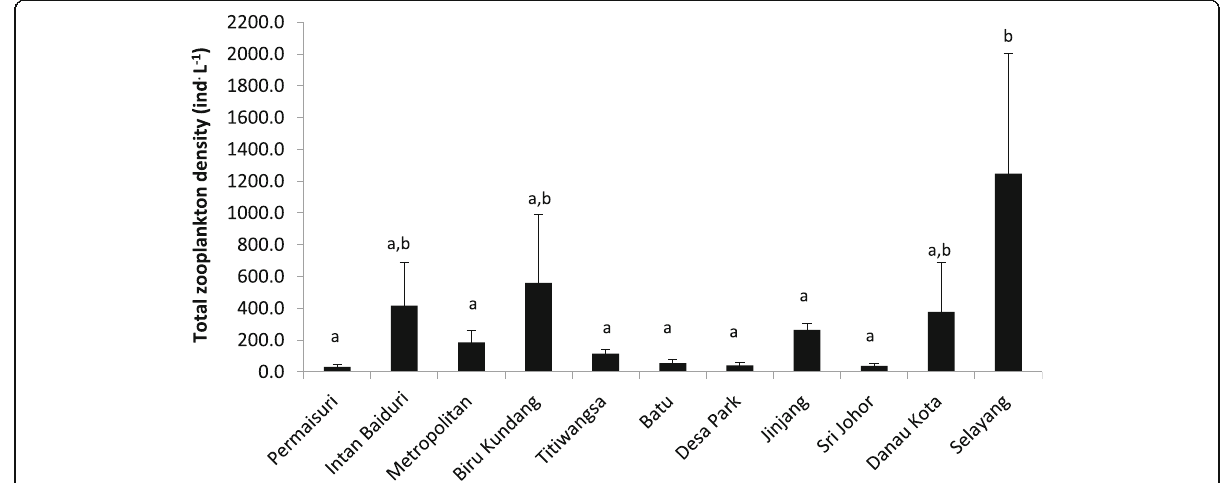
Fig. 2 Total zooplankton density (ind. L − 1 ) in studied lakes and ponds. Different superscripts show a significant difference ( p <